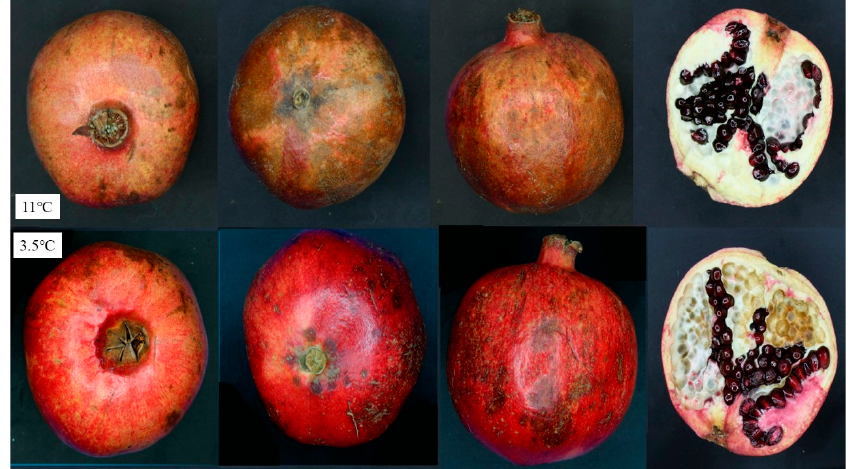
Figure 1. Husk scald and chilling injury in pomegranate “Wonderful” fruit skin after 120 days of storage at 11 and 3.5 °C and ≥ 95% RH, respectively.